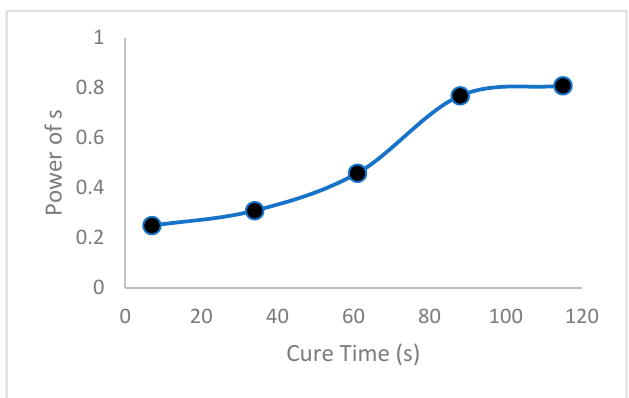
Figure 6. Power of s in adhesive cure.